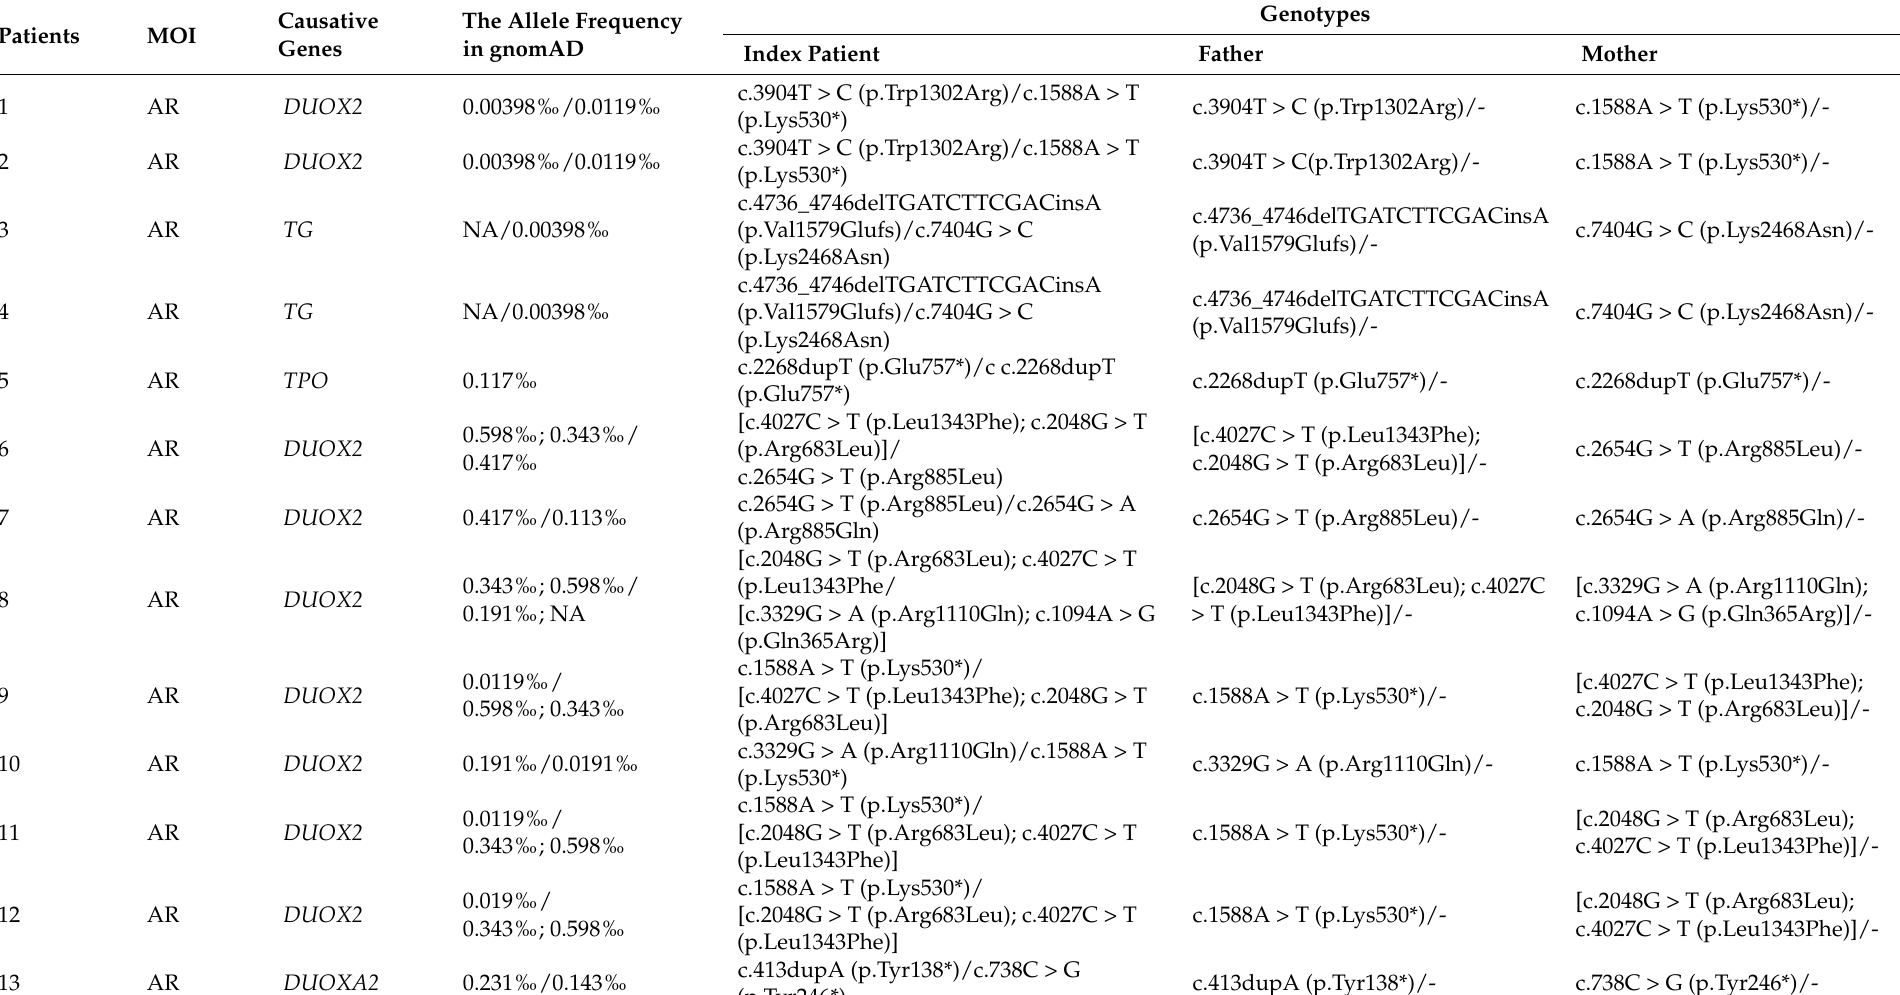
Table 1. Genotyping results of the 22 CH patients with clear genetic